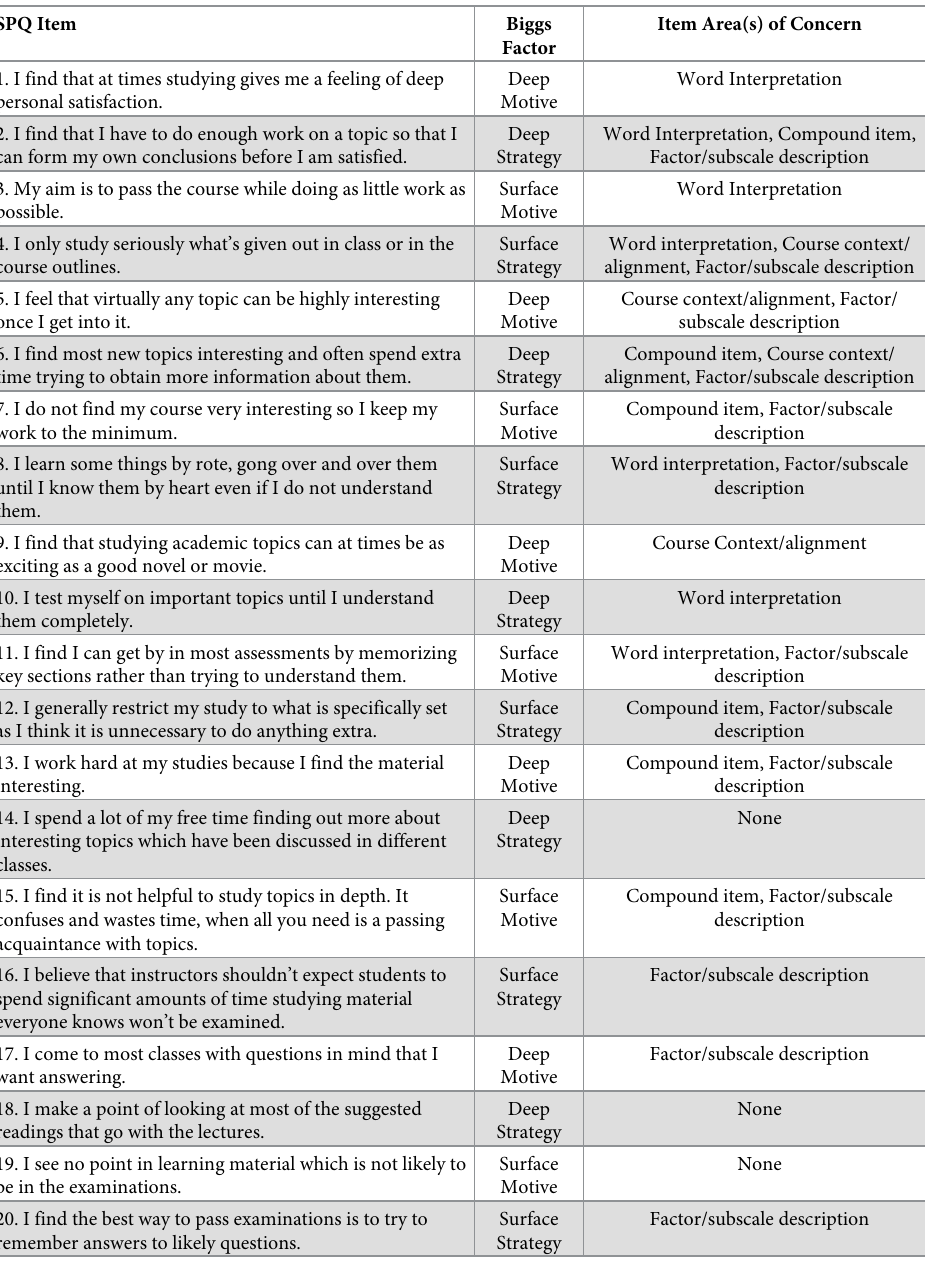
Table 5. Results from item review by the research team. SPQ Item Biggs